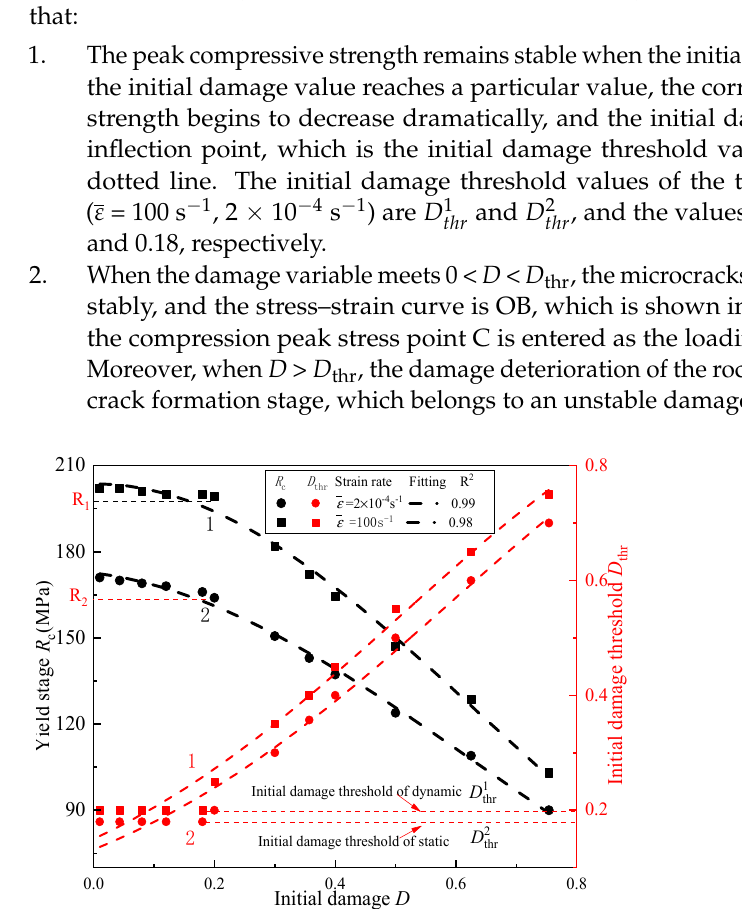
Figure 14. Plot of the damage threshold versus the initial damage curves for limestone from 2 × 10 − 4 , 100 s − 1 levels of strain rate .